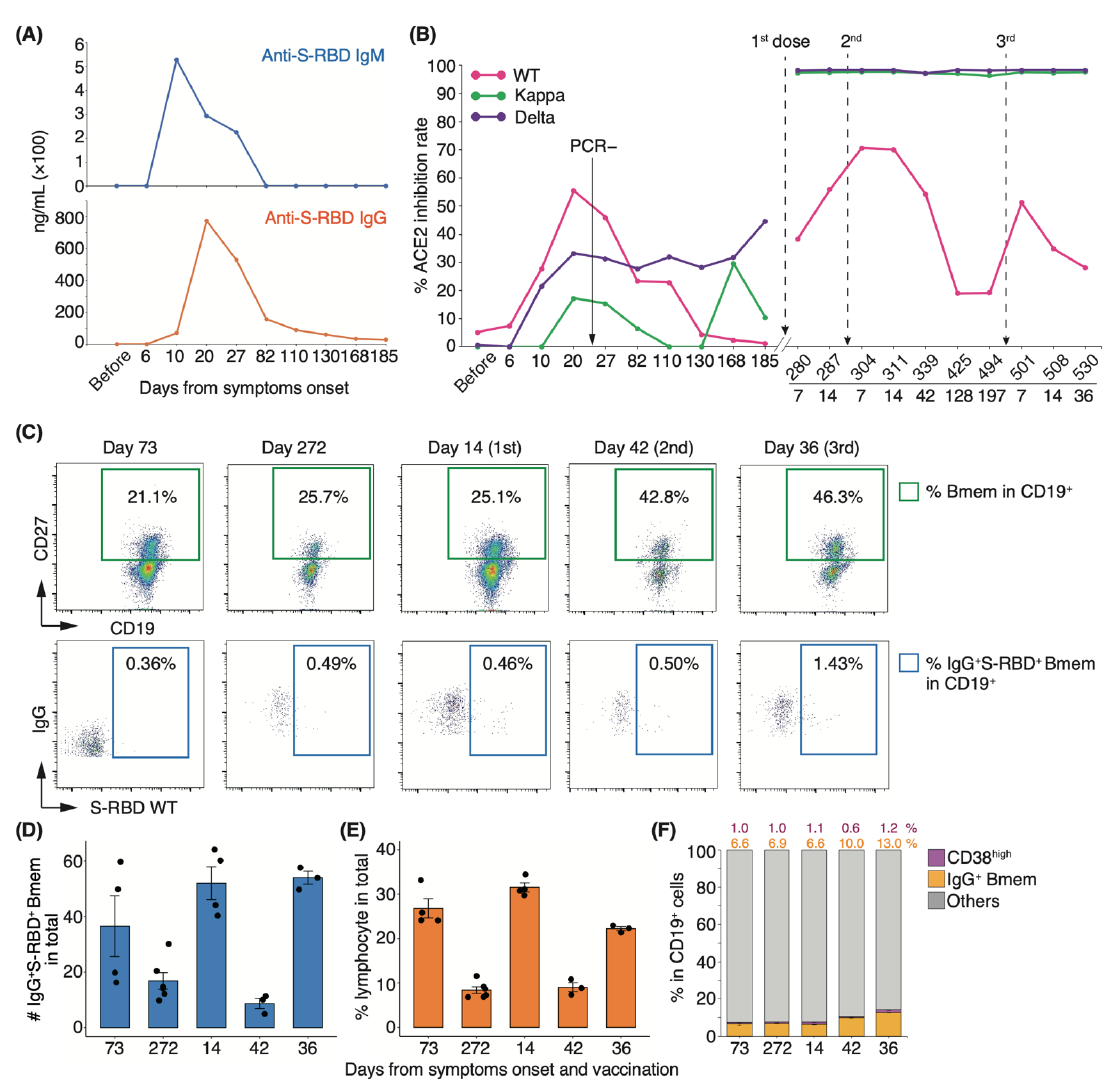
Figure 5. Longitudinal analyses of serum neutralizing antibody activities and PBMCs in a patient with high neutralizing potency: ( A ) Concentration of anti-S-RBD IgM and IgG in the serum of a healthcare worker (indicated by # in Figure 1) upon infection. ( B ) Fluctuation of each neutralizing antibody titer from onset to post-vaccination ( n = 1). ( C ) Representative FACS plots of cell population are shown in panels. The numbers indicate the positive rate of each cell population. Graphs show the absolute number of IgG + S-RBD + Bmems ( D ) and the frequency of lymphocyte ( E ), CD19 + CD27 + CD38 high , and IgG + Bmems (( F ); n = 1, 3–5 technical replicates). Black dots indicate technical replicates. Each number indicates the